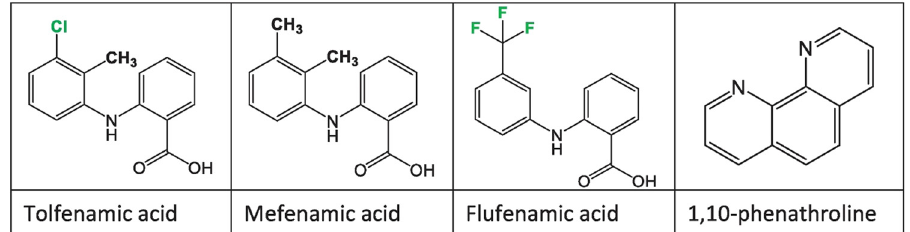
Figure 1: The structures of ligands used for preparation of studied Cu ( II )